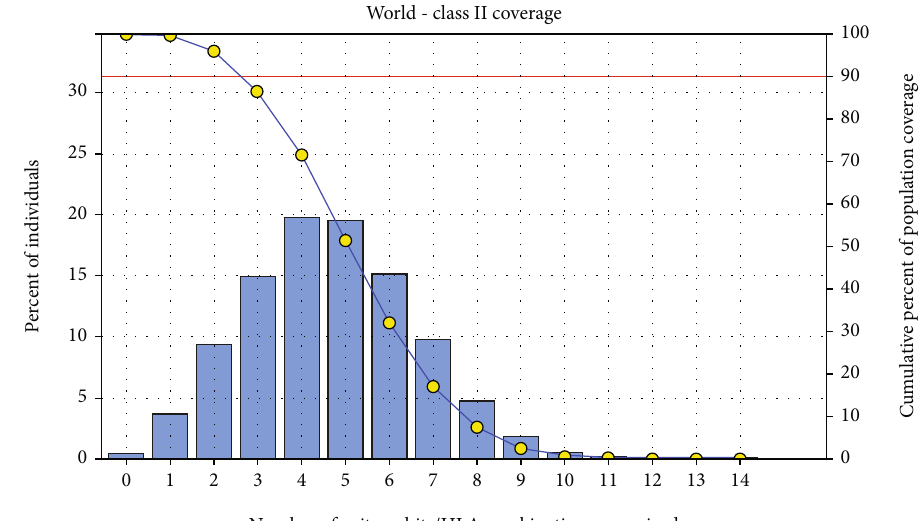
Figure 6: Global proportion for the top fi ve MHC II IRGSIAAAH, LFSSHMLDL, and VVAALEAAR. Notes: in the graph, the line (-o-) represents the cumulative percentage of population coverage of the epitopes; the bars represent the population coverage for each